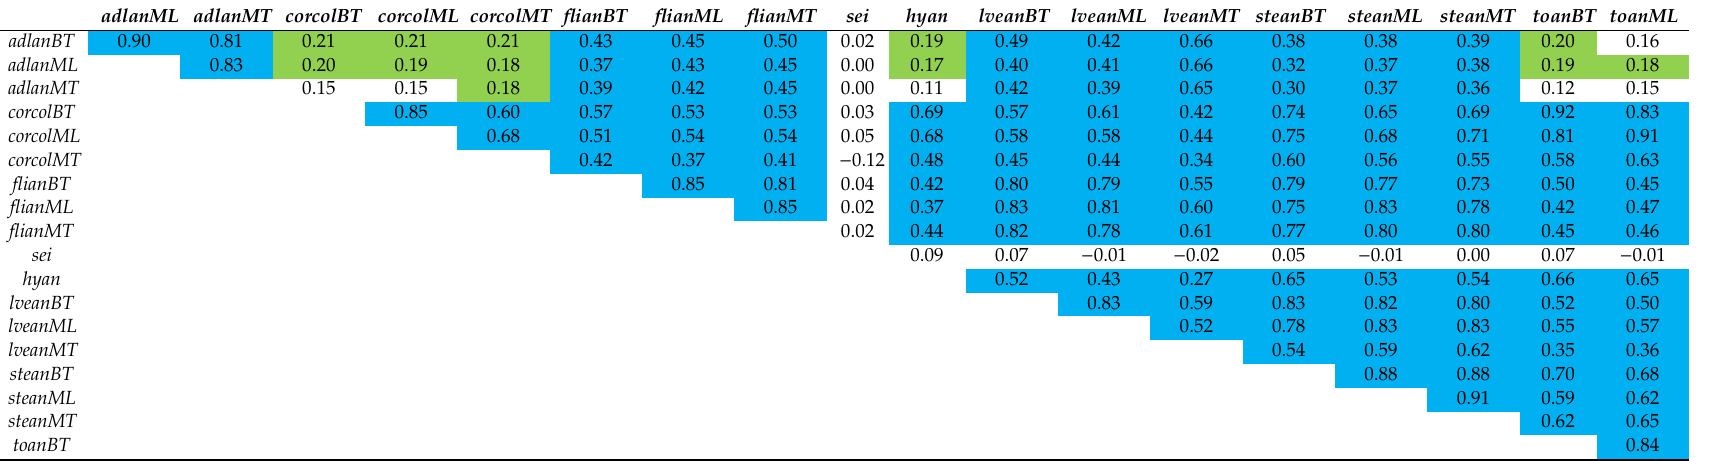
Table 3. Inter-trait Spearman correlations assessed in the mapping population. In green, significant correlation at p < 0.05, in blue at p < 0.01. adlanML adlanMT corcolBT corcolML corcolMT